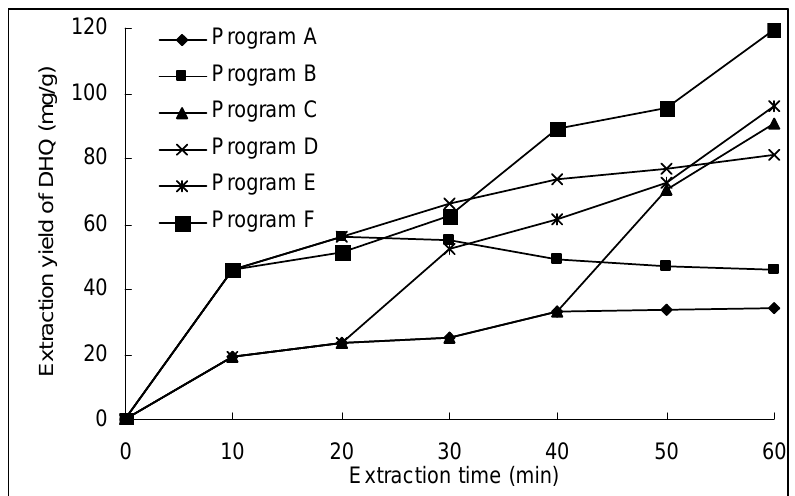
Figure 3. Alternant extraction by UAE and